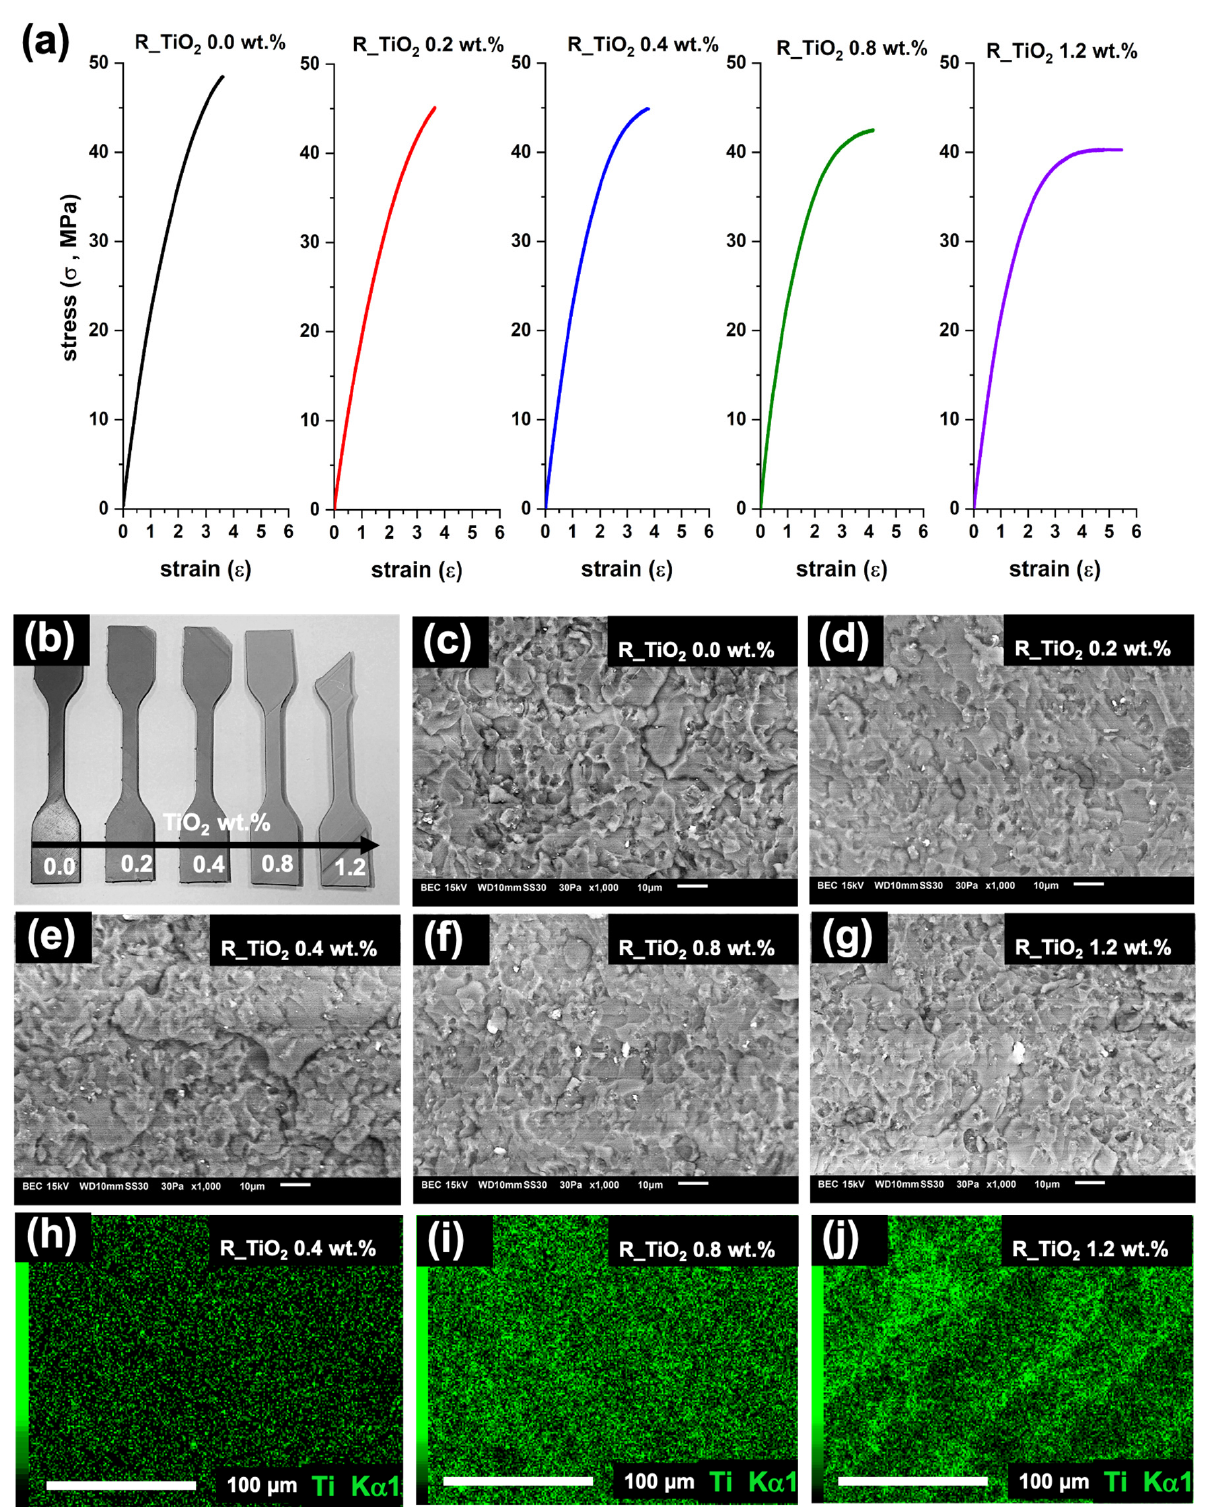
Figure 4. ( a ) Stress–strain behaviors of 3D-printed polymer nanocomposites based on resin/TiO 2 NPs (R_TiO 2 X wt.%, where X = 0.0, 0.2, 0.4, 0.8, or 1.2); ( b ) 3D-printed tensile bars of each nanocomposite system (dog–bone type); ( c – g ) fracture images by SEM on the transversal section; ( h – j ) elemental mapping by EDS corresponding to some representative 3D-printed polymer nanocomposites (R_TiO 2 X